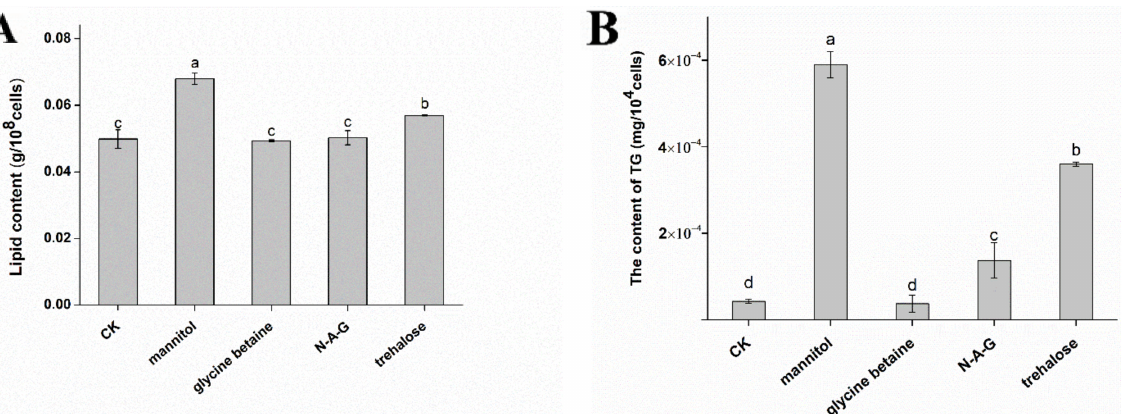
Figure 5. Effects of different exogenous regulators on the total lipid and triglyceride accumulation: ( A ) lipid content and ( B ) TG content. The data are from three independent repeated experiments. The different letters above the bars indicate a significant difference in the lipid content or TG content for each treatment, according to the least significant difference test ( p <